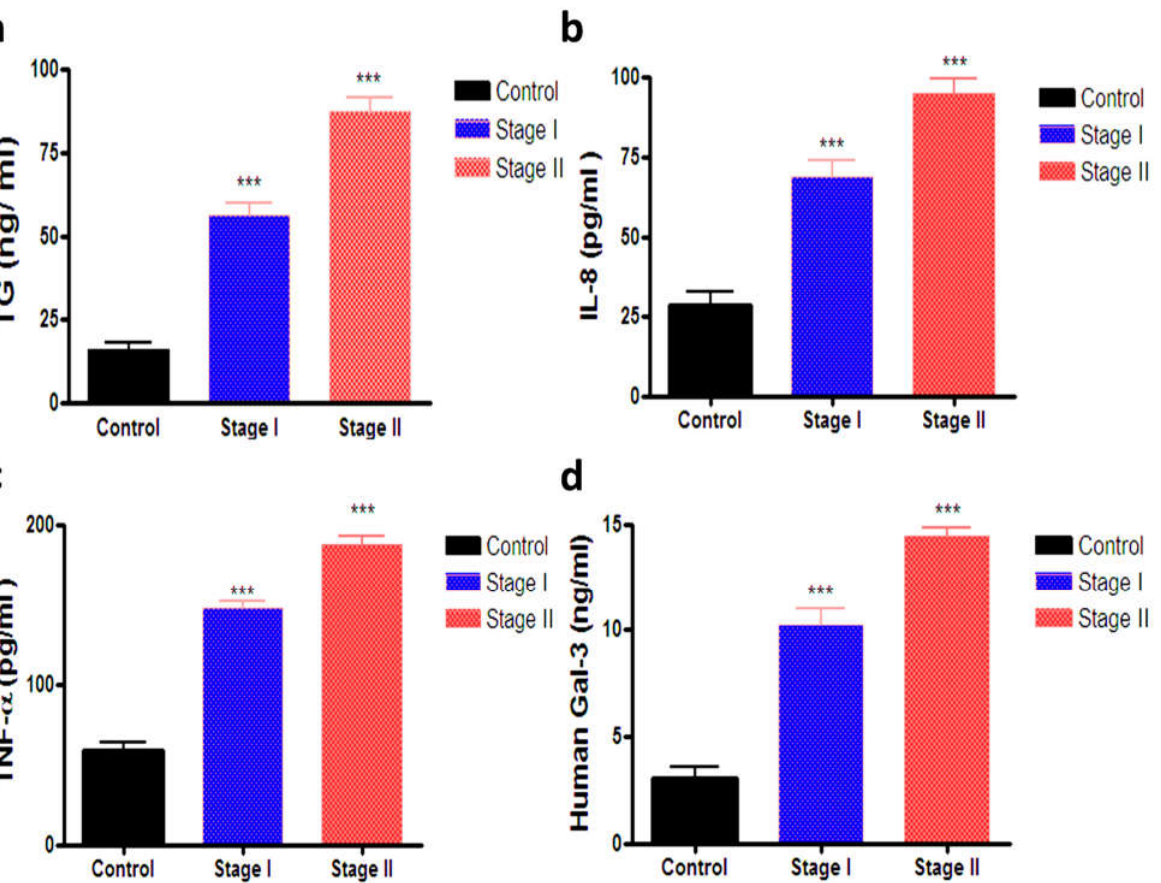
Figure 2. The serum levels of ( a ) TG, ( b ) IL-8, ( c ) TNF-α, ( d ) Gal-3 by using ELISA technique. Data wereexpressed as the mean ± SD. Data were analyzed using one-way ANOVA followed by Tukey post-hoc test at p < 0.05, Significant difference from the control group *** p < 0.001, ** p < 0.01.